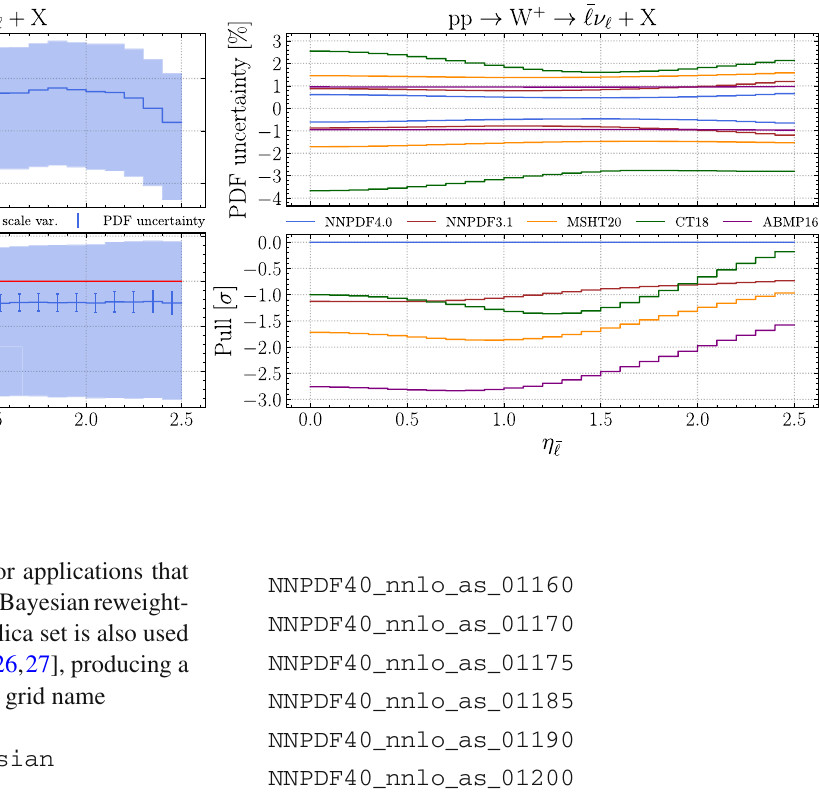
ing the 7-point scale variation uncertainties; the percentage shift in cen- tral values between pure QCD and QCD+EW along with the PDF and scale variation uncertainties (bottom left), all for NNPDF4.0; the rela- tive PDF uncertainties for all PDF sets (top right); and the pull defined in Eq. (9.3) between results obtained using NNPDF4.0 and each of the other PDF sets (bottom right)